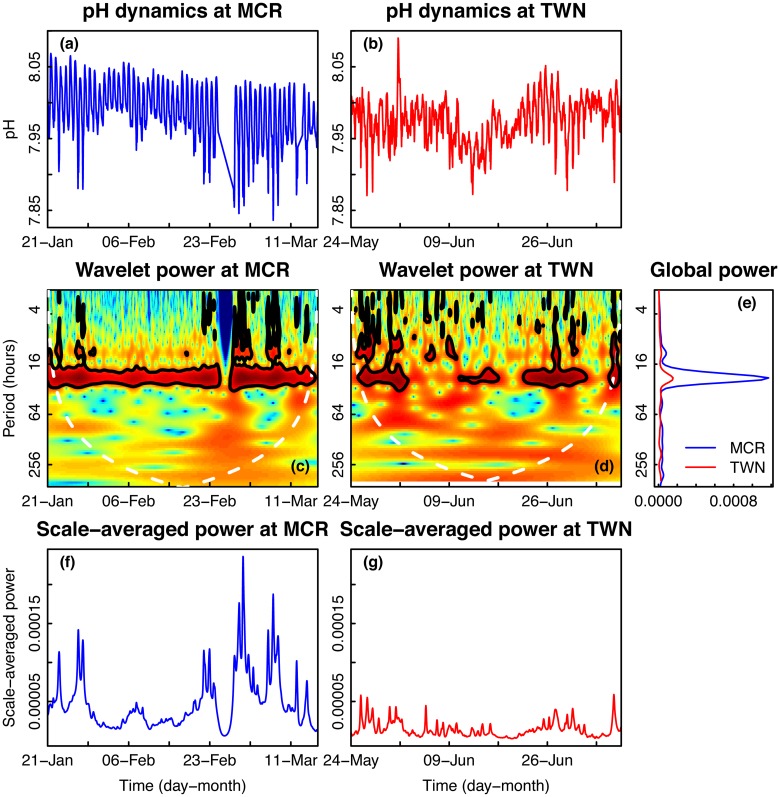
Time series and wavelet power analyses of seawater pH.Time series plots of seawater pH collected on a fringing reef in (a) Moorea [MCR], French Polynesia and (b) Taiwan [TWN]. Wavelet power quantifies the changes in relative contribution of each period in the pH signal to the overall variance of the signal for time series collected in (c) Moorea and (d) Taiwan. High power is represented in warm colors and low power is represented in cold colors. Black contours designate regions of significantly high temporal variation compared to a null model (red noise). The white line represents the cone of influence—values outside of this region are less reliable due to edge effects in the analysis. (e) Sites were compared using wavelet power integrated over time. Wavelet power was also integrated over period to describe changes in total variance over time for MCR (f) and TWN (g).